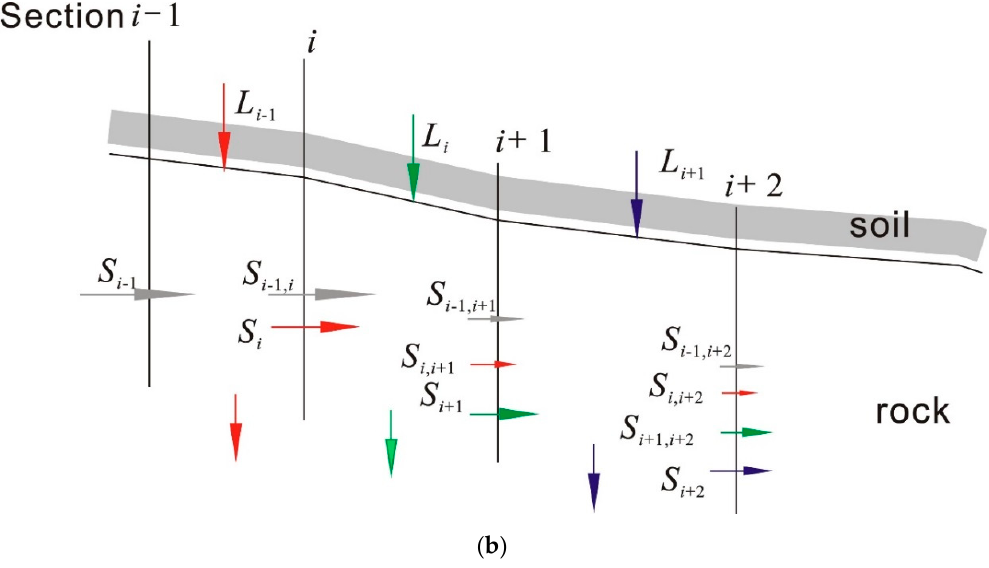
Figure 3. Illustration of ( a ) subsurface flow in the rock and ( b ) the procedure of the stepwise method used to calculate the subsurface lateral flow process.